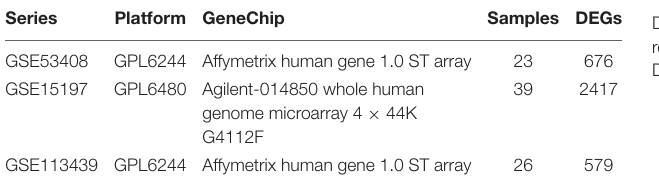
TABLE 1 | Summary of pulmonary arterial hypertension datasets.